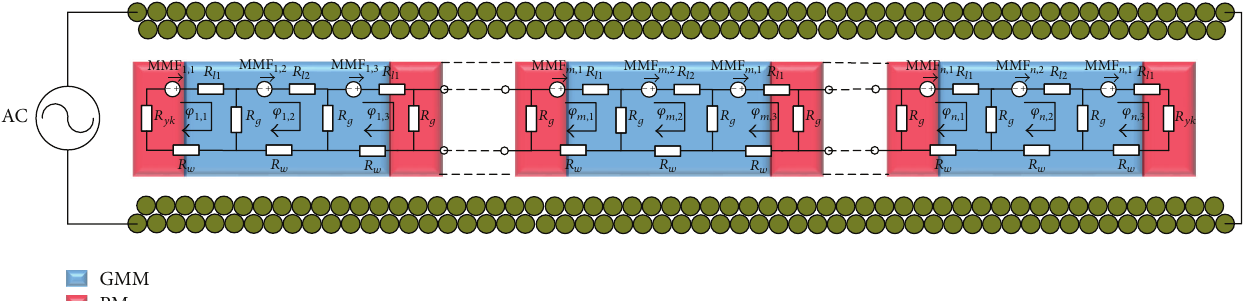
Figure 7: Overall magnetic circuit model for the linear-arrayed GMA.